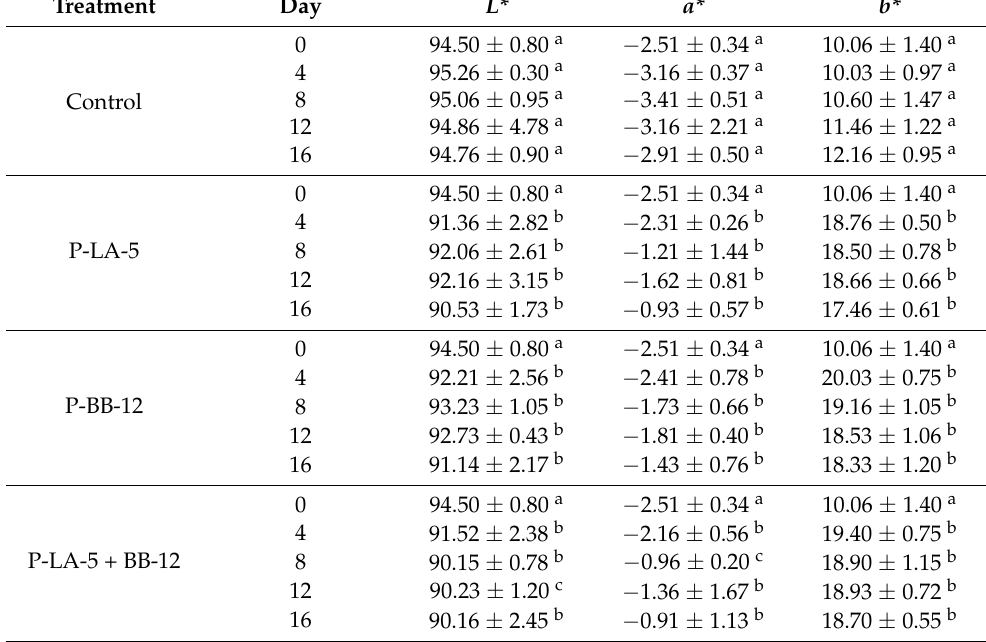
lowercase letters indicate a significant ( p < 0.05) difference between treatments on each storage